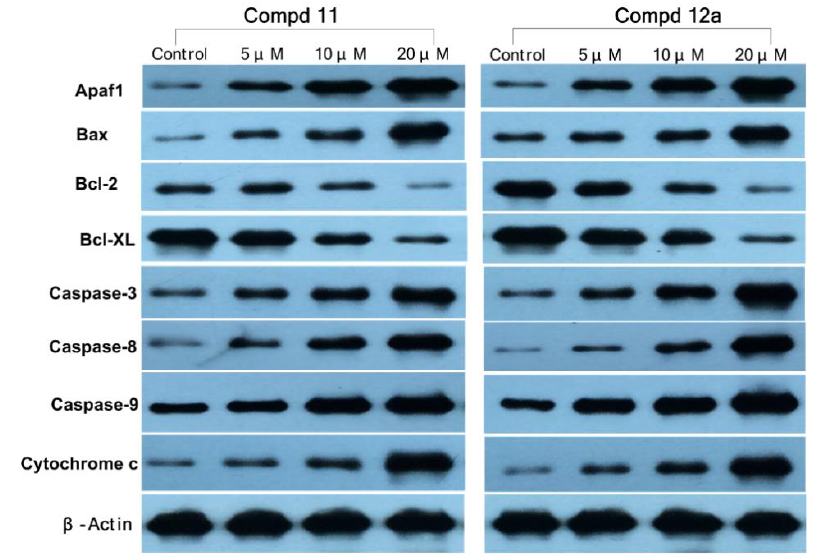
Figure 8. The protein expressions of Apaf-1, Bax, Bcl-2, Bcl-xL, caspase-3, caspase-8, caspase-9, and cytochrome c in MCF-7 cells treated with compounds 11 / 12a in western blotting assay. Cells were treated with various concentrations (0, 5, 10, and 20 µM) of 11 / 12a for 72 h.